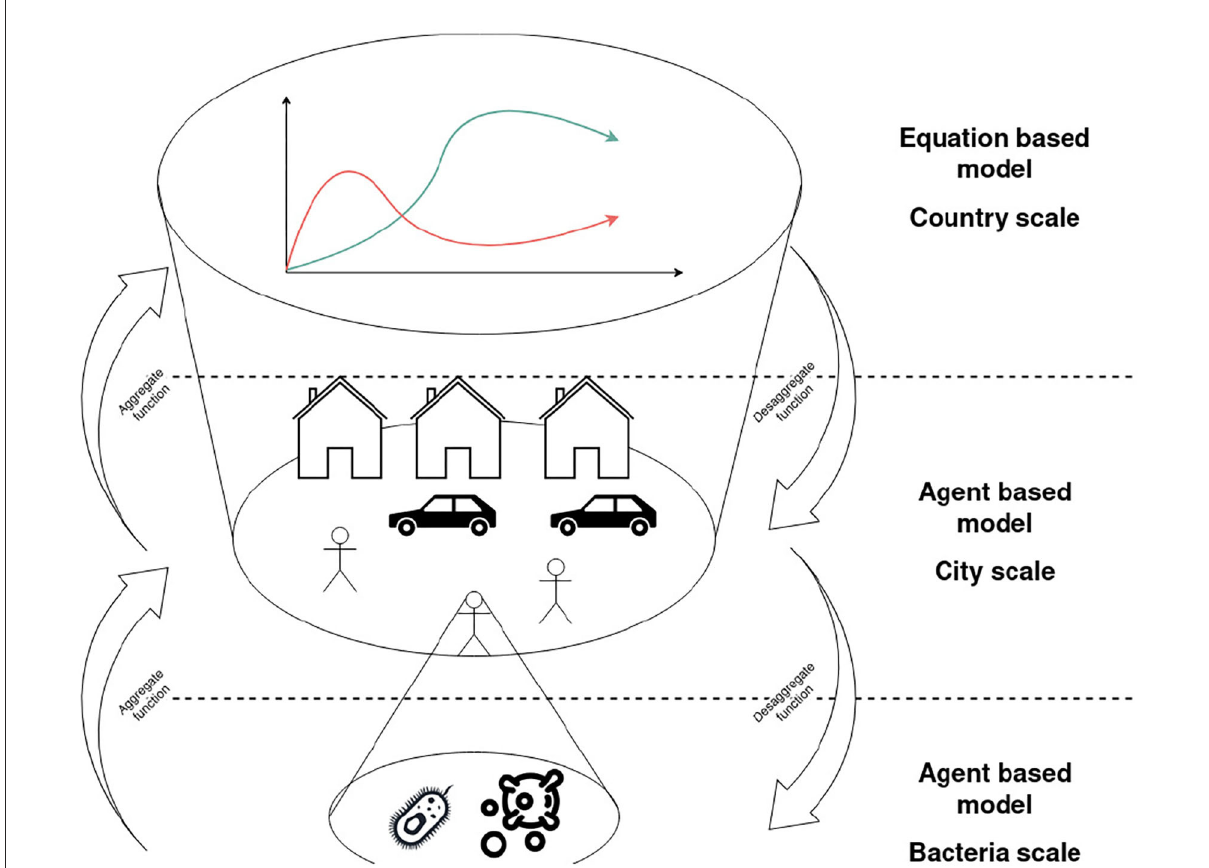
FIGURE2 Simplified representation of the zoom